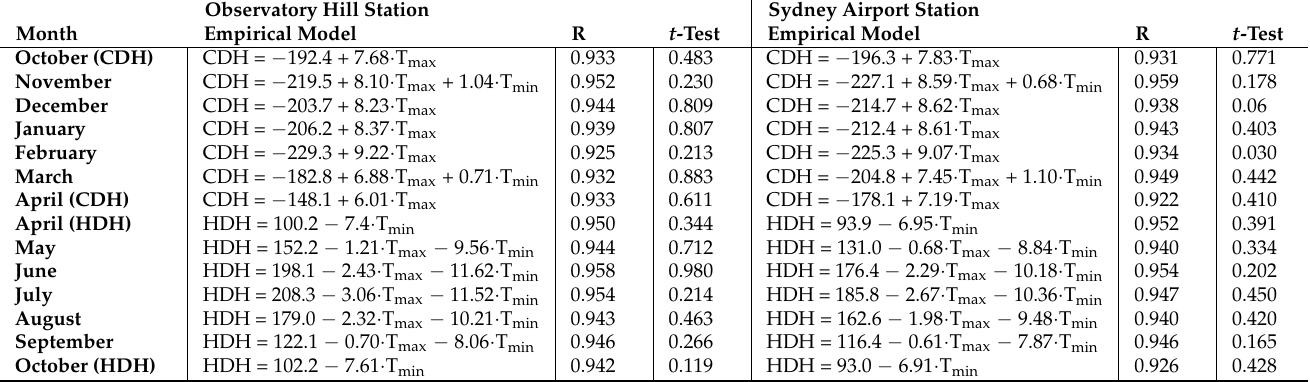
Table 3. Monthly empirical equations for estimations of daily values of CDH and HDH, the corresponding correlation coefficients and the paired t -test values of goodness of fit with the observed daily values of 2019. Observatory Hill